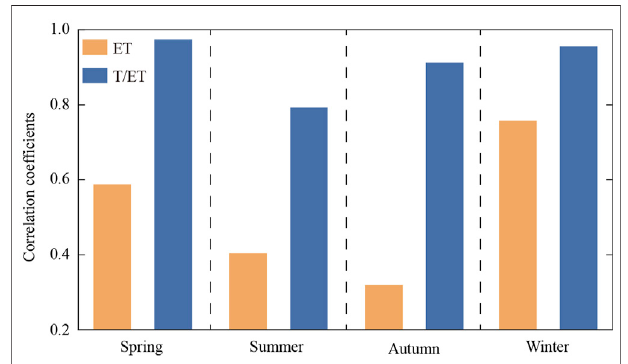
FIGURE 4 | Correlation coef fi cients of interannual variability of Δ LAI with Δ ET and Δ (T/ET).